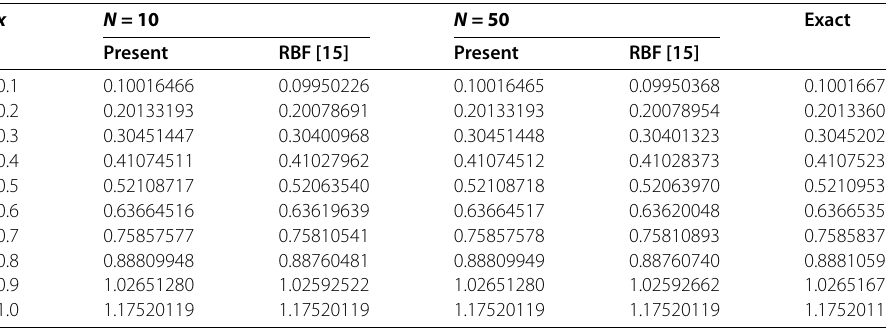
Table 8 The comparison of results for Example 3 when N = 50 and γ = 1.25 at t =